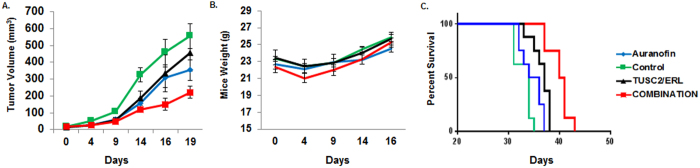
Auranofin/TUSC2/erlotinib inhibits tumor growth and prolong animal survival significantly.A subcutaneous mouse model of the human NSCLC using H1299 cells was adopted to evaluate effect the trinary combination: Auranofin plus systemic delivery of DC-based TUSC2 nanoparticles, and erlotinib. (A) Tumor volumes were calculated taking length of the longest diameter across the tumor and with width of the corresponding perpendicular diameter using the formula: length x width2 × 0.52. The rate of tumor growth inhibition was calculated as 100% × (treated tumor size/control tumor size). (B) Mice were weighed throughout the experiments. (C) Overall survival of animals with various treatments were estimated by Kaplan-Meier method. Log-rank (Mantel-Cox) test was performed to compare overall survival between TUSC2/erlotinib treated mice and TUSC2/erlotinib/Auranofin treated mice (P < 0.0001).